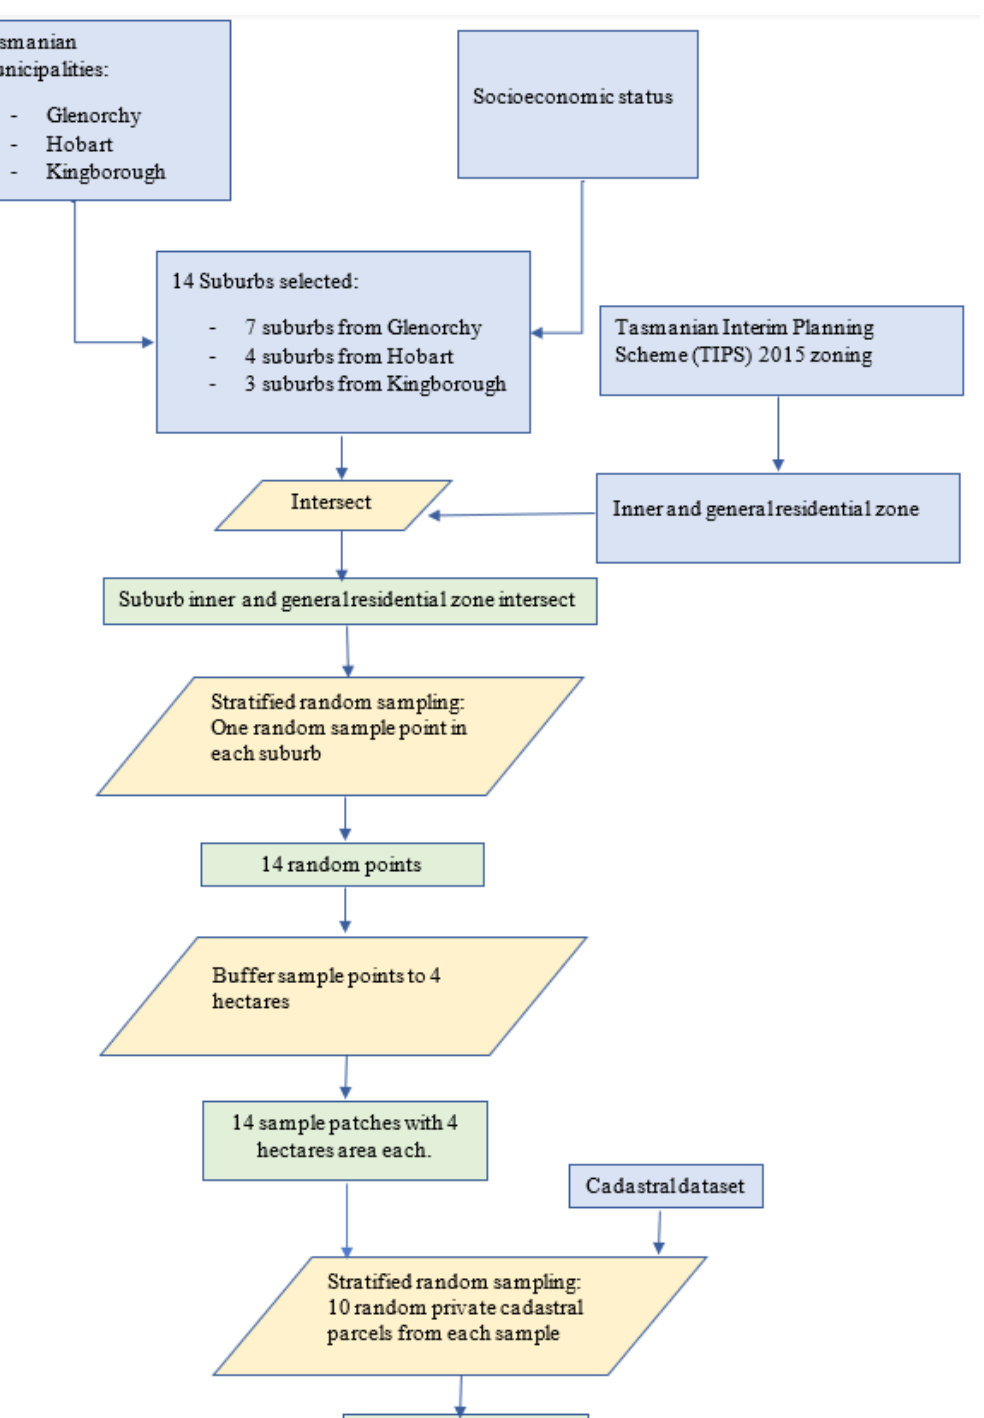
Figure 3. Sample patch and parcel selection methodology applied in this research; different boxes represent the sequential steps followed in executing the research.